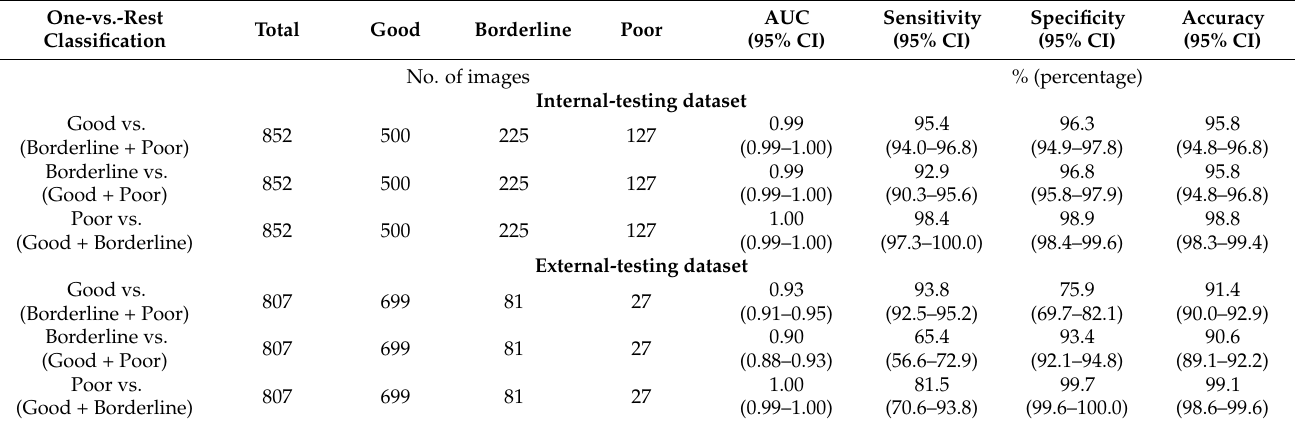
Figure 4. Receiver operating characteristic curves (ROC) and areas under the curves (AUC) of individual folds for the 5-fold cross-validation performed on the testing dataset. ( a ) “good” quality versus (“borderline” and “poor” quality) images; ( b ) “borderline” quality versus (“good” and “poor” quality) images and ( c ) “poor” quality versus (“good” and “borderline” quality) images. Table 2. Classification Performance of the Deep-Learning System on the Internal-testing and External- testing